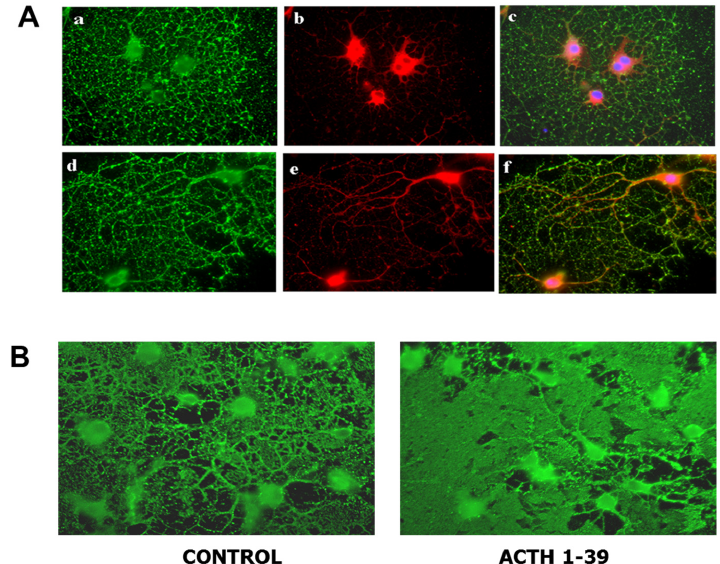
Figure 2. Oligodendroglia express melanocortin receptors and produce larger membrane sheets in response to ACTH. ( A ) Mixed glial cultures from rat brain were immunostained with antibody for MC4R (red) before ( a – c ) and after ( d – f ) permeabilization to visualize surface and total